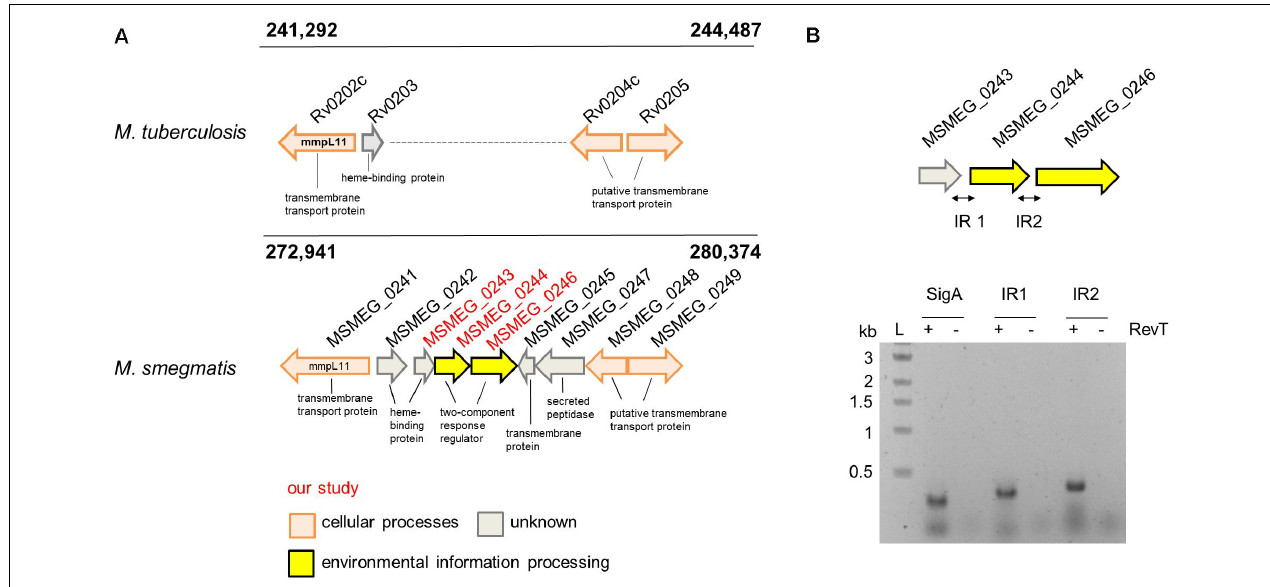
FIGURE 1 | The potential heme uptake and lipid export locus in M. tuberculosis and M. smegmatis . (A) Alignment of the genomic region surrounding additional five genes located on the M. sm genome. Highlighted in red: the three genes investigated in our study. (B) Operon analysis by RT-PCR of msmeg_0243 , msmeg_0244, and msmeg_0246 confirmed the co-transcription of these three genes. Analysis was performed in the presence ( + ) or absence ( − ) of reverse transcriptase (RevT). IR, intergenic region. Expected PCR product size IR1: 336 bp, IR2: 378